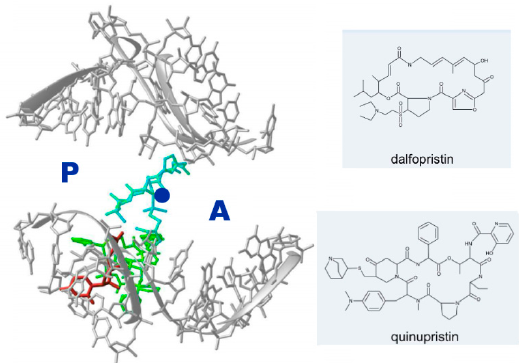
Figure 4. View into the PTC (rRNA backbone in grey), in which the approximate peptide bond formation position is marked by a blue circle, and the A- and P-sites tRNA 3 ′ -ends are marked by A and P. Shown also are the locations of two components of Synercid™ (chemical formulas shown on the right side) within the PTC and in the tunnel’s entrance (dalfopristin in cyan and quinupristin in green). Note the swung location, out of the active site of nucleotide U2585 (in red).